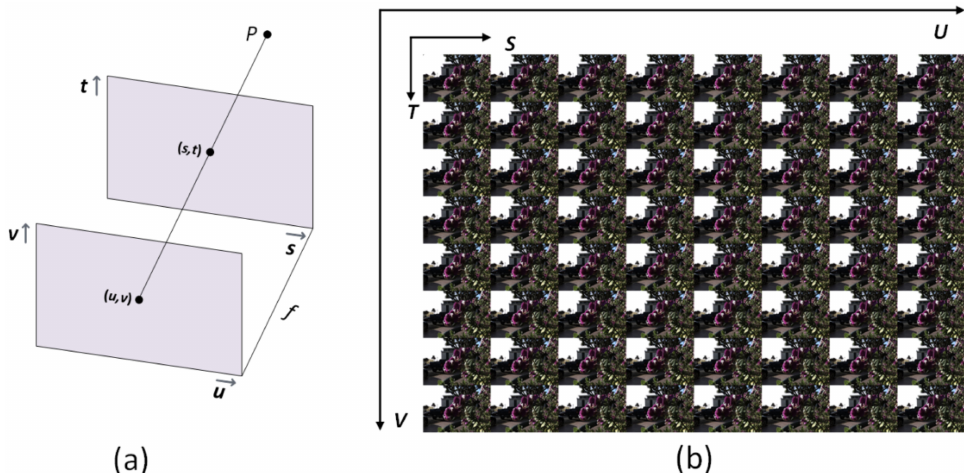
Figure 2. Parameterization and visualization of 4D LF. ( a ) L ( u , v , s , t ) denotes the light beam from an arbitrary point P that crosses the two planes at the angular ( u , v ) and spatial ( s , t ) positions. ( b ) The 4D LF may be seen as a 2D array of view images, with neighboring images differing slightly from one